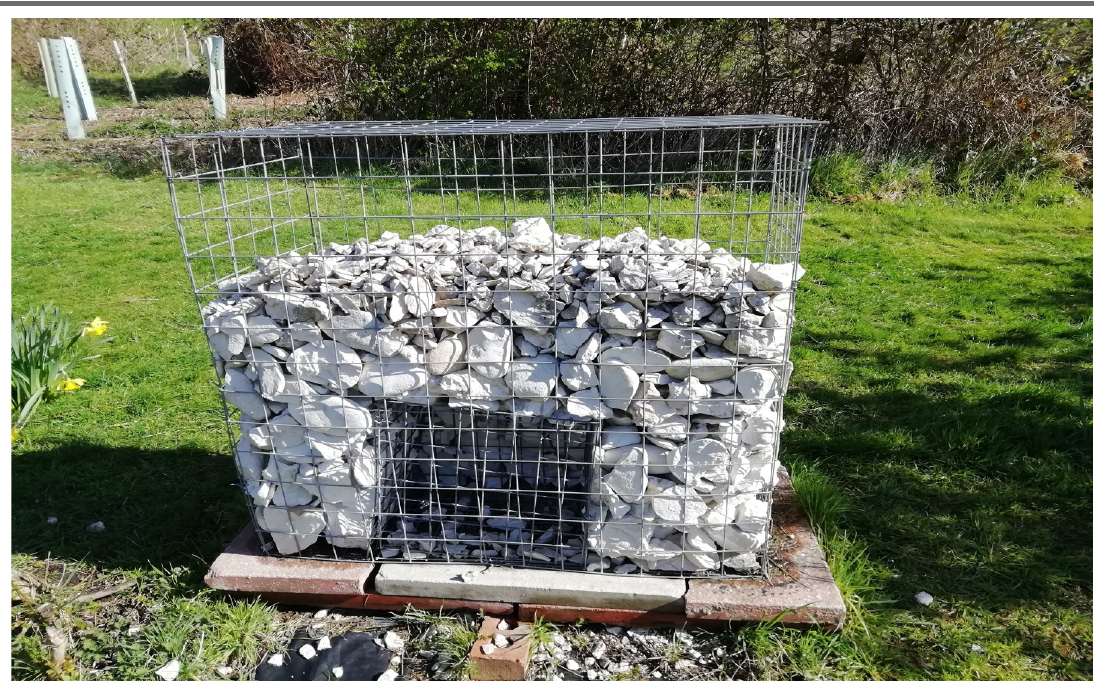
Figure 4. A gabion being used to display cobbles and pebbles of Cretaceous aged chalk (coccolithic limestone) in a purpose built geo-educational setting. These cobbles are derived from the glacial deposits and show a lithology rarely seen in outcrop other than working quarries or coastal exposures and are poorly suited to use as a building stone. Here it has been made avail- able for study in the urban